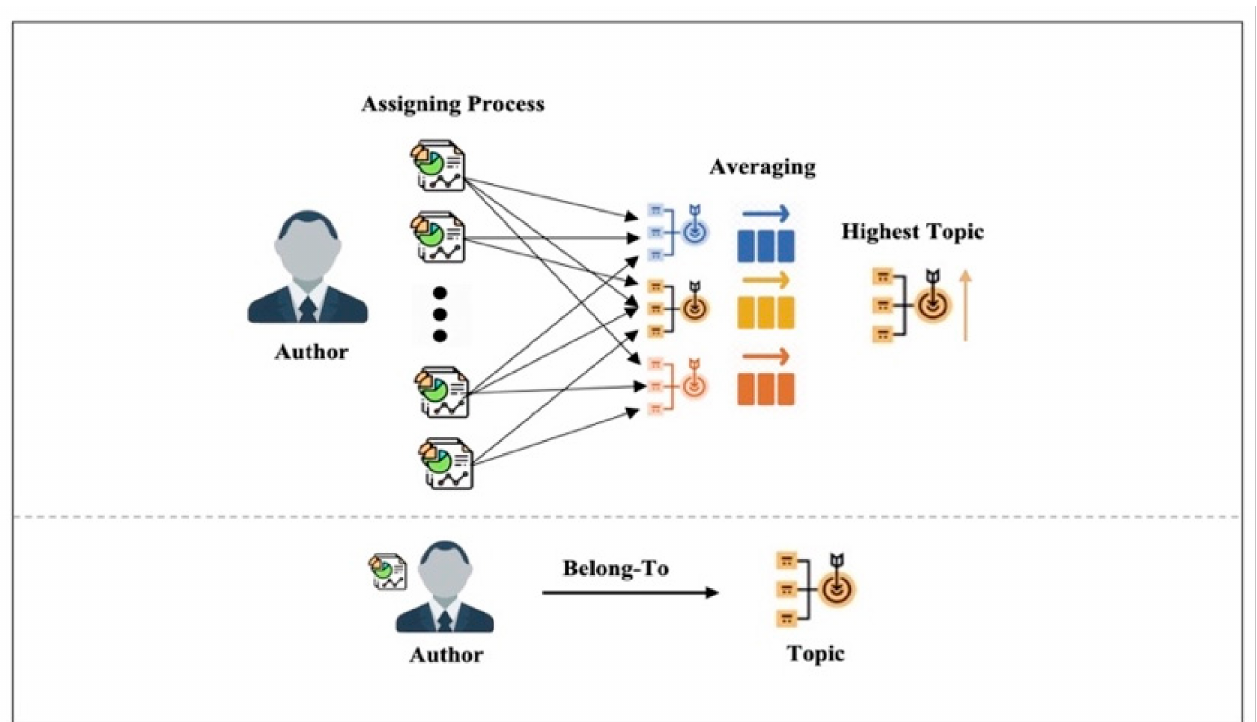
Figure 7. Assigning process for the author’s main research